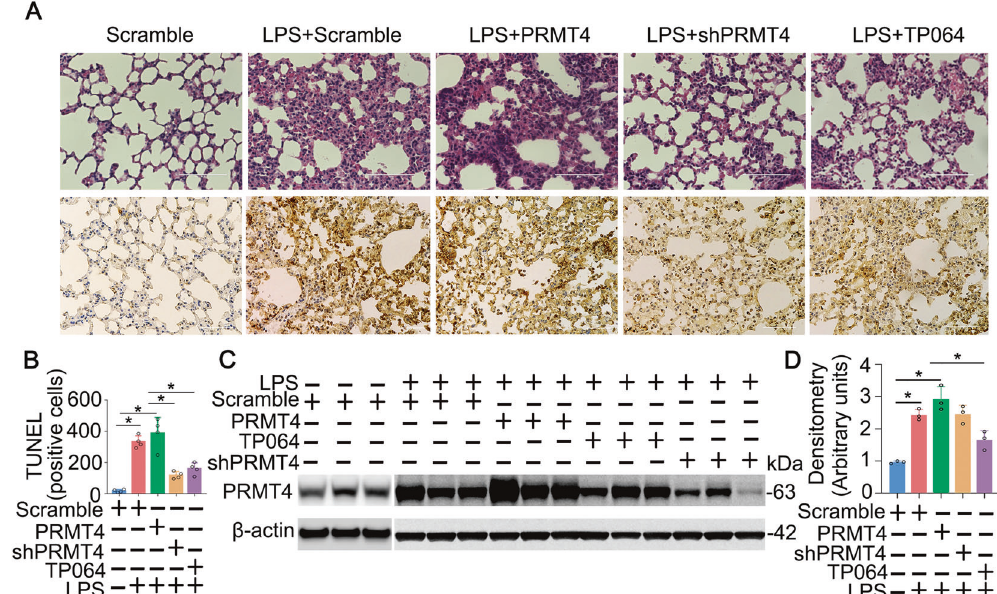
Fig. 7 Inhibition of PRMT4 suppresses cell death in a LPS lung injury model. A – D PRMT4 was silenced or overexpressed by i.t. administered lentiviral constructs for 14 days. Mice were then given (i.t.) LPS with or without a PRMT4 inhibitor as indicated for 24 h ( n = 8). Lung tissues were stained with hematoxylin – eosin (H&E) ( A , upper panels) and TUNEL staining ( A , lower panels). B TUNEL-positive cells in lung tissues were quantitated. C PRMT4 overexpression and knockdown in lung tissues from A were analyzed by immunoblotting. The data from C were quantitated and plotted in D ( n = 3). * P < 0.05 vs. scrambled control. Scale bar = 100 μ